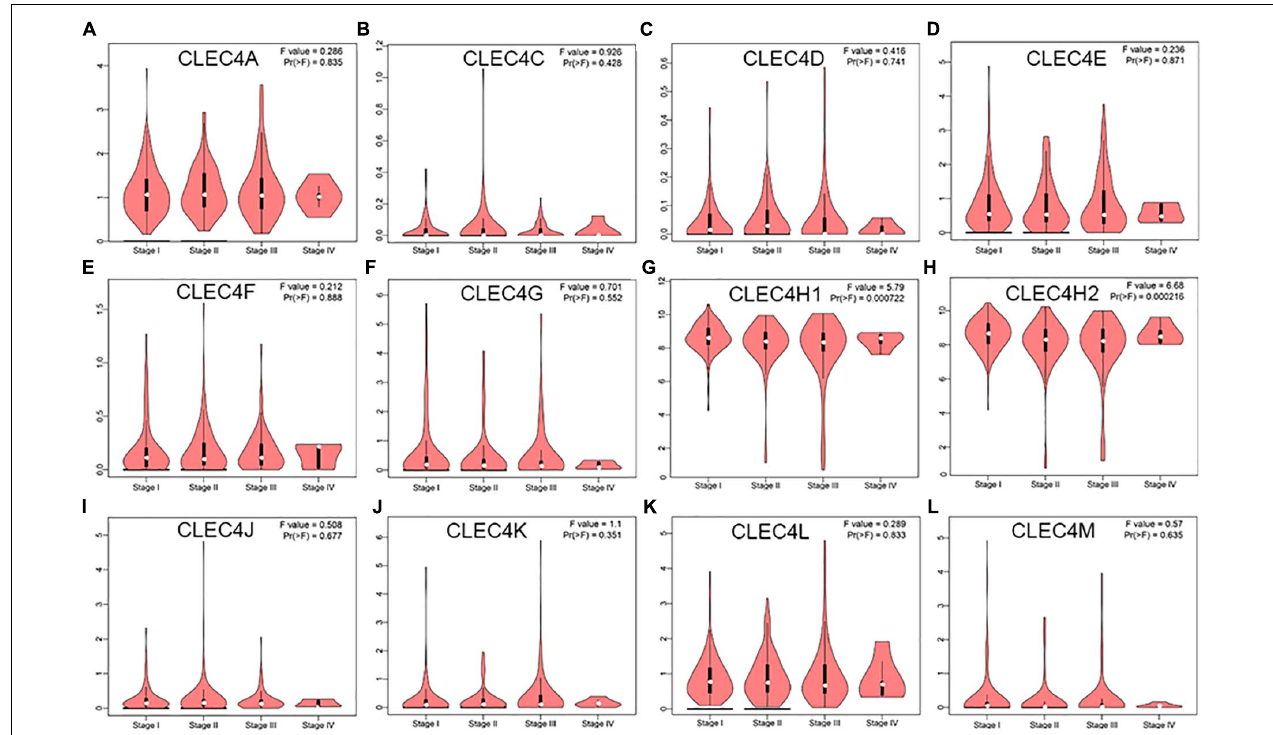
FIGURE 5 | The correlation between CLEC4s with stage of HCC patients (GEPIA). (A) CLEC4A; (B) CLEC4C; (C) CLEC4D; (D) CLEC4E; (E) CLEC4F; (F) CLEC4G; (G) CLEC4H1; (H) CLEC4H2; (I) CLEC4J; (J) CLEC4K; (K) CLEC4L; (L) CLEC4M.